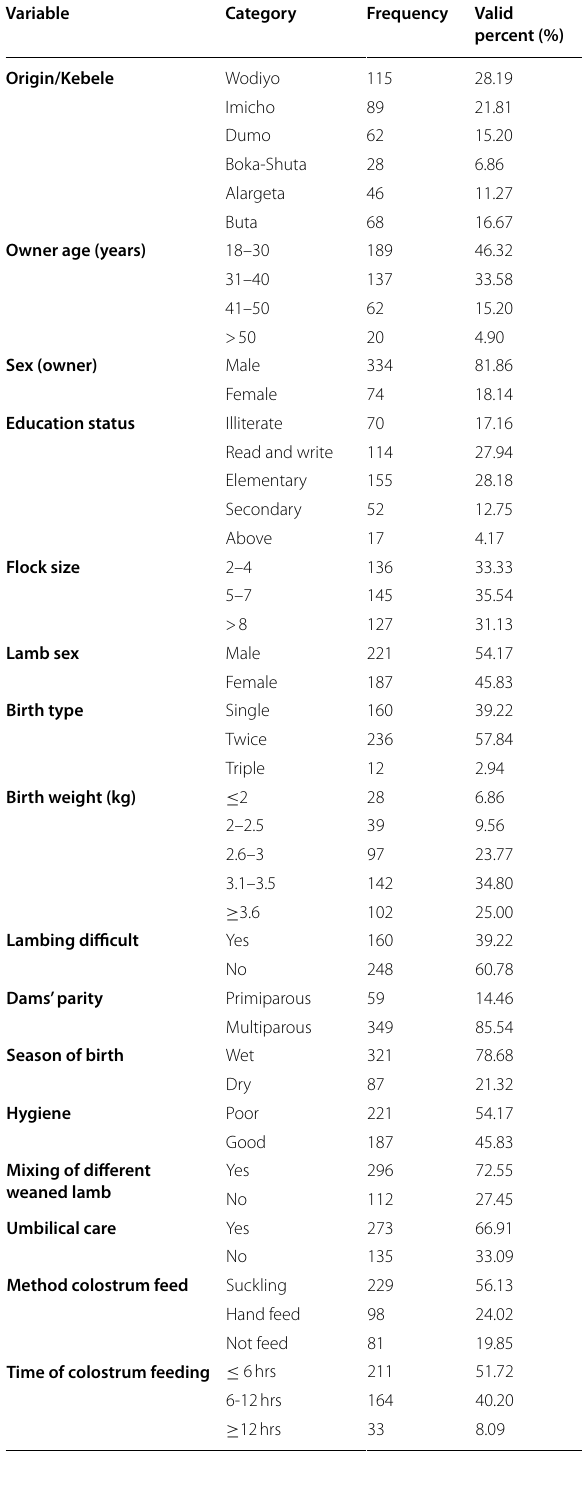
Table 1 Respondents’ feedback on their demography, lambs’ health, and management in the mixed crop-livestock production system of Southwest